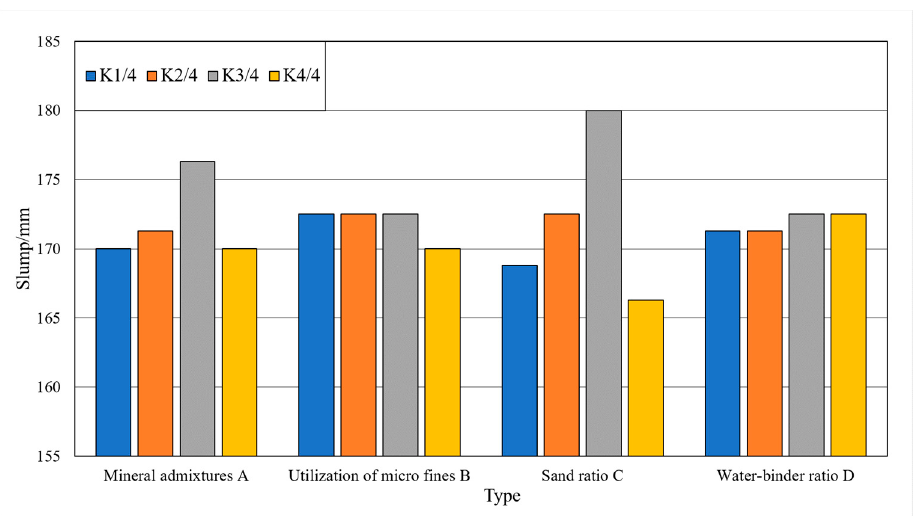
Figure 4. Trend of the influence of factors on slump test results.